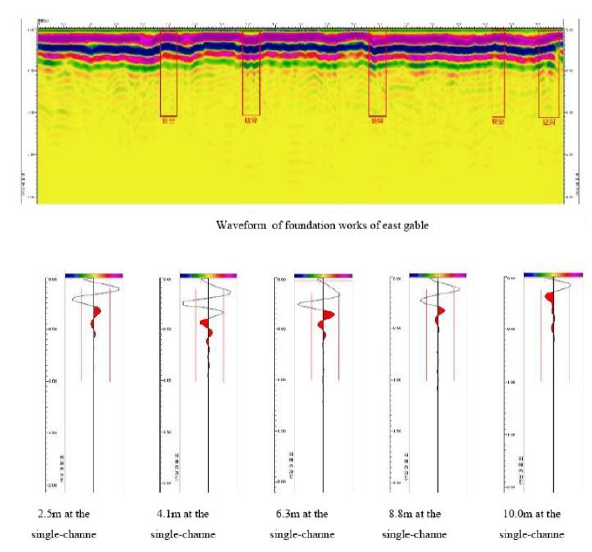
Figure 8 GPR analysis of the main hall of the east gable